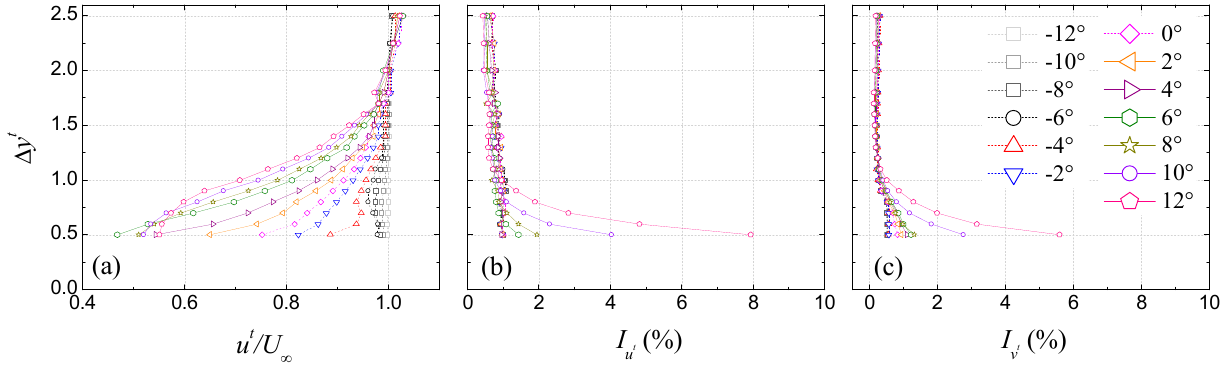
Figure 5. Profiles of flow approaching the train model at various angles of attack: ( a ) Normalized mean velocity in streamwise direction; ( b ) Turbulence intensity in streamwise direction; and ( c ) Turbulence intensity in vertical direction.